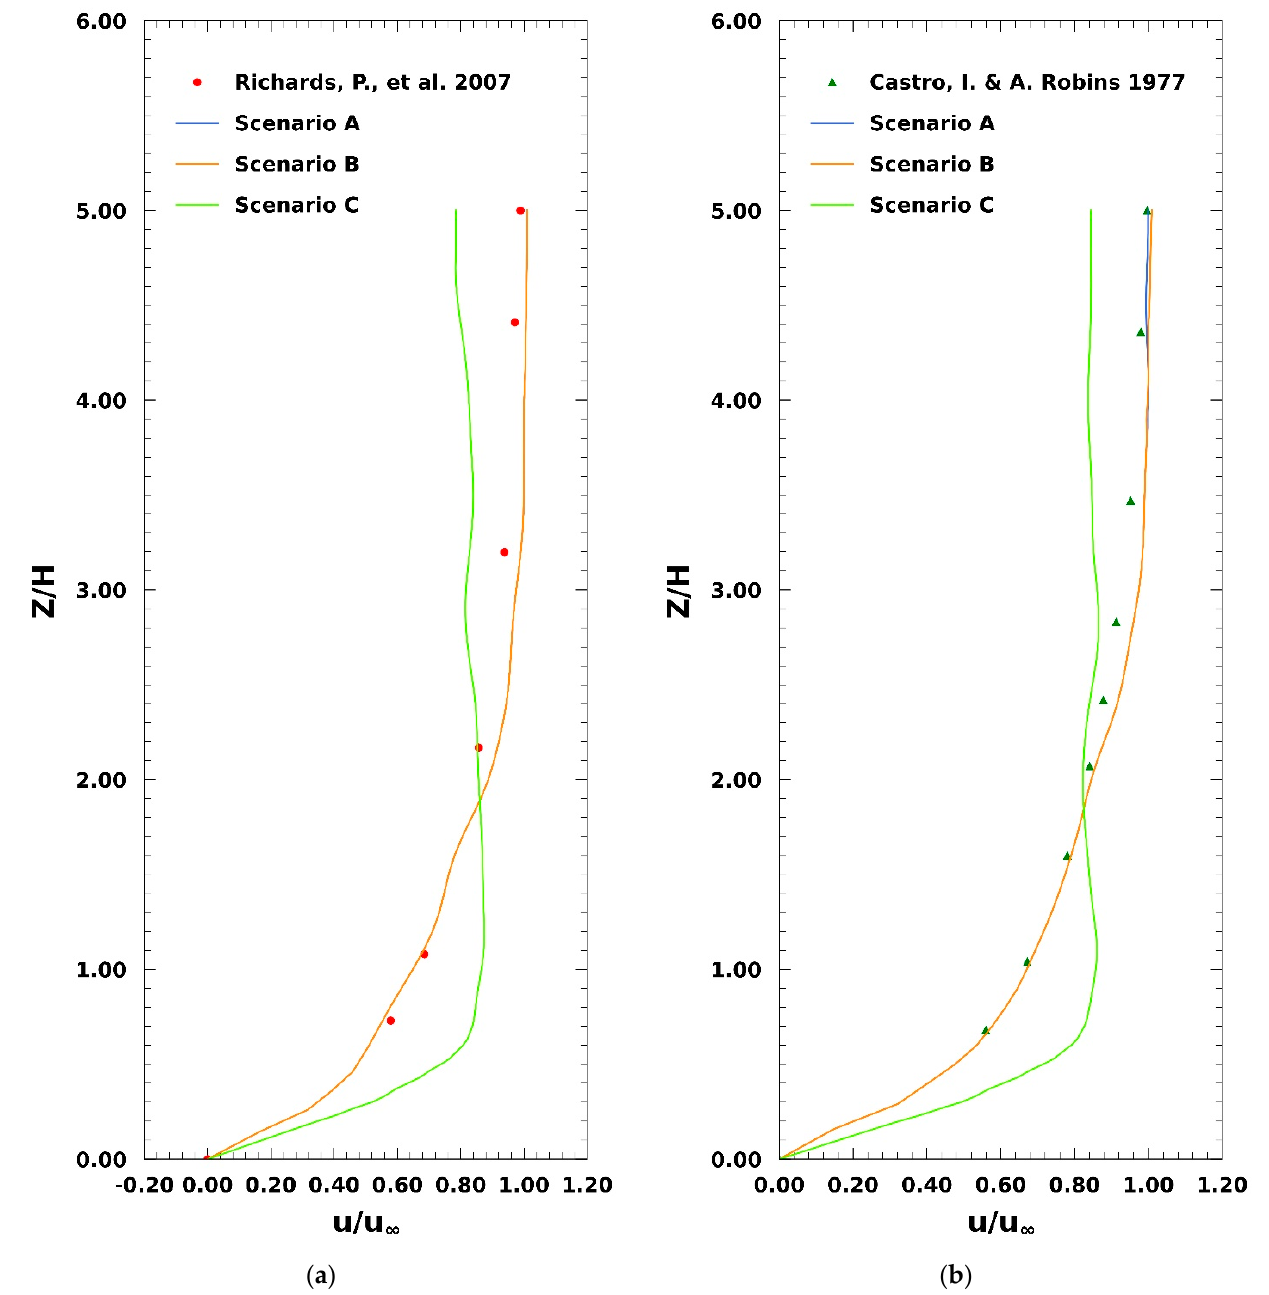
Figure 2. Normalized velocity profiles at the ( a ) inlet of the computational domain and ( b ) X/H = 2 position from the inlet for Scenarios A − C.